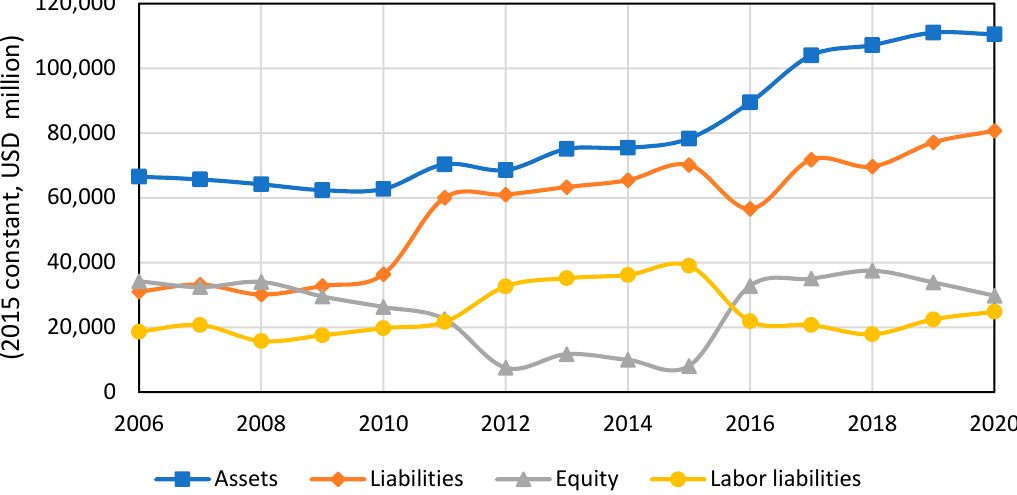
Figure 4. CFE’s equity in the period 2006–2020.